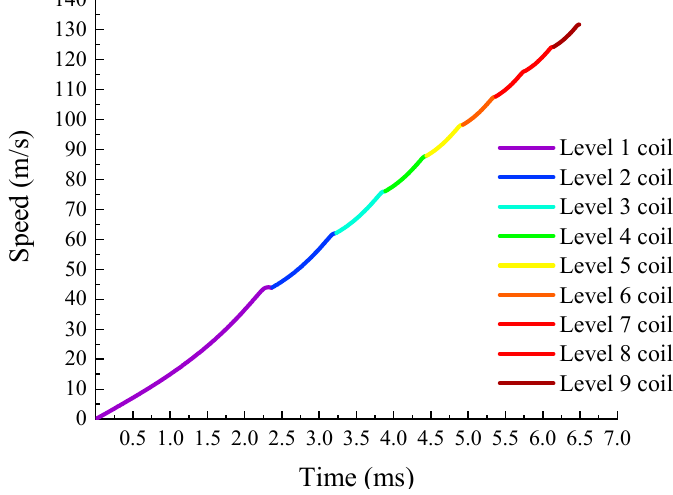
Figure 10. The electromagnetic force of the 45 mm continuous acceleration coil.